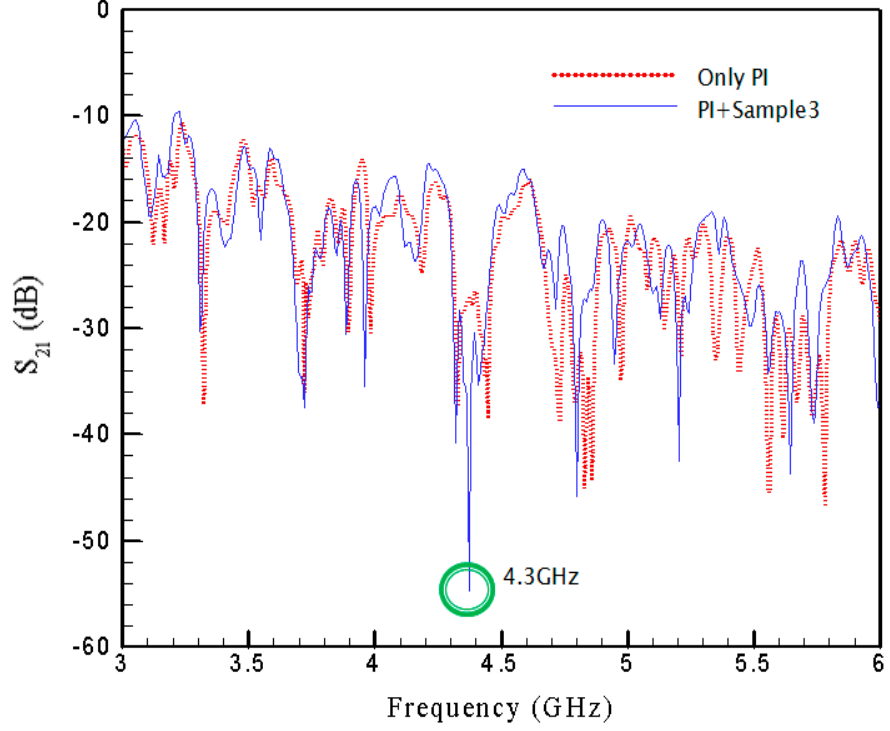
Figure 10. Transmission coefficient with SRR3.